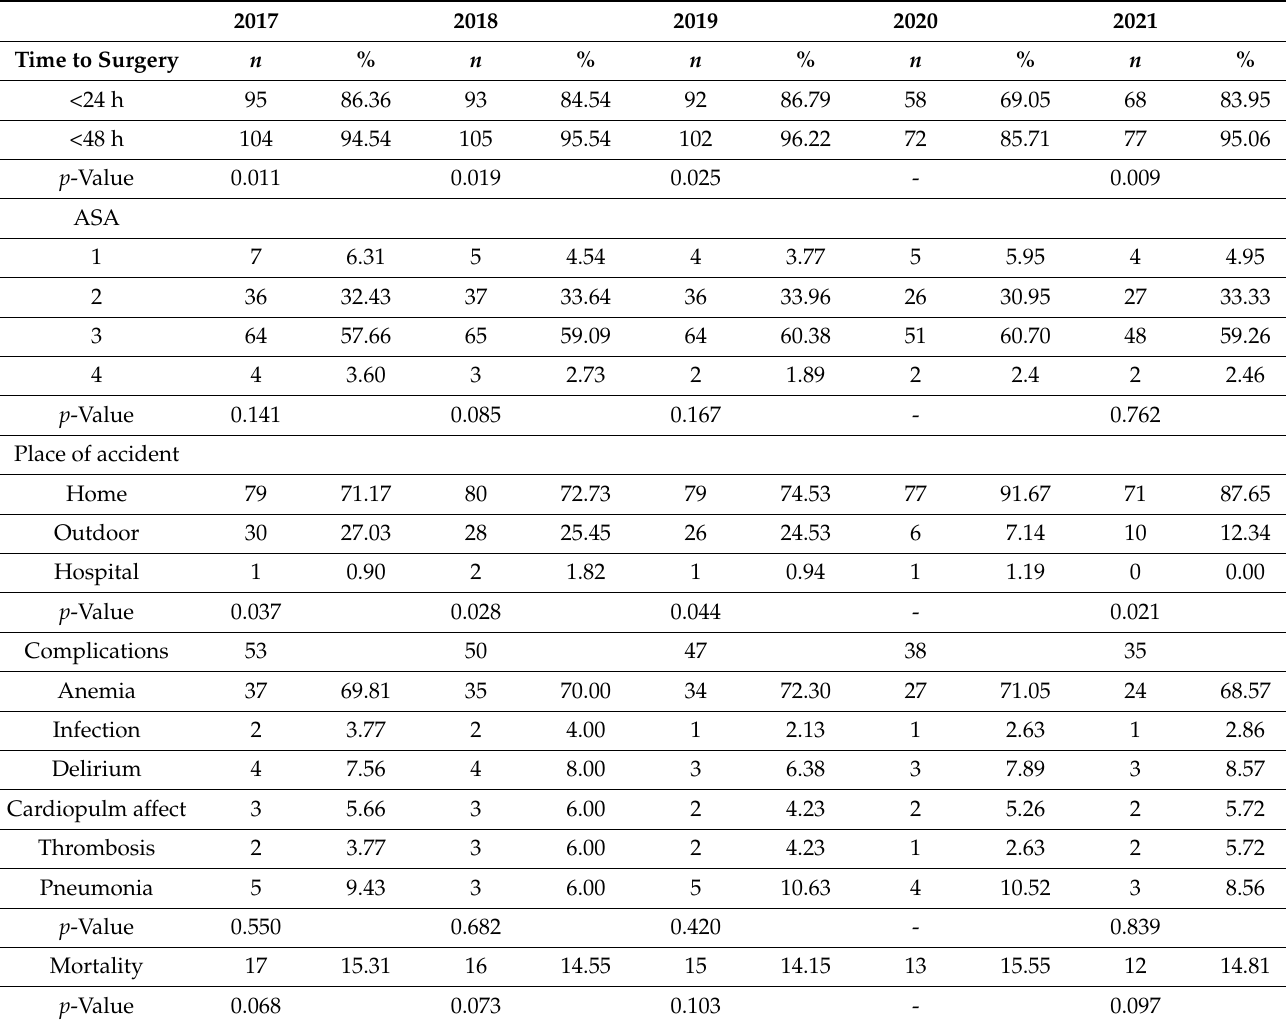
Table 2. Epidemiological data—surgical and general characteristics.